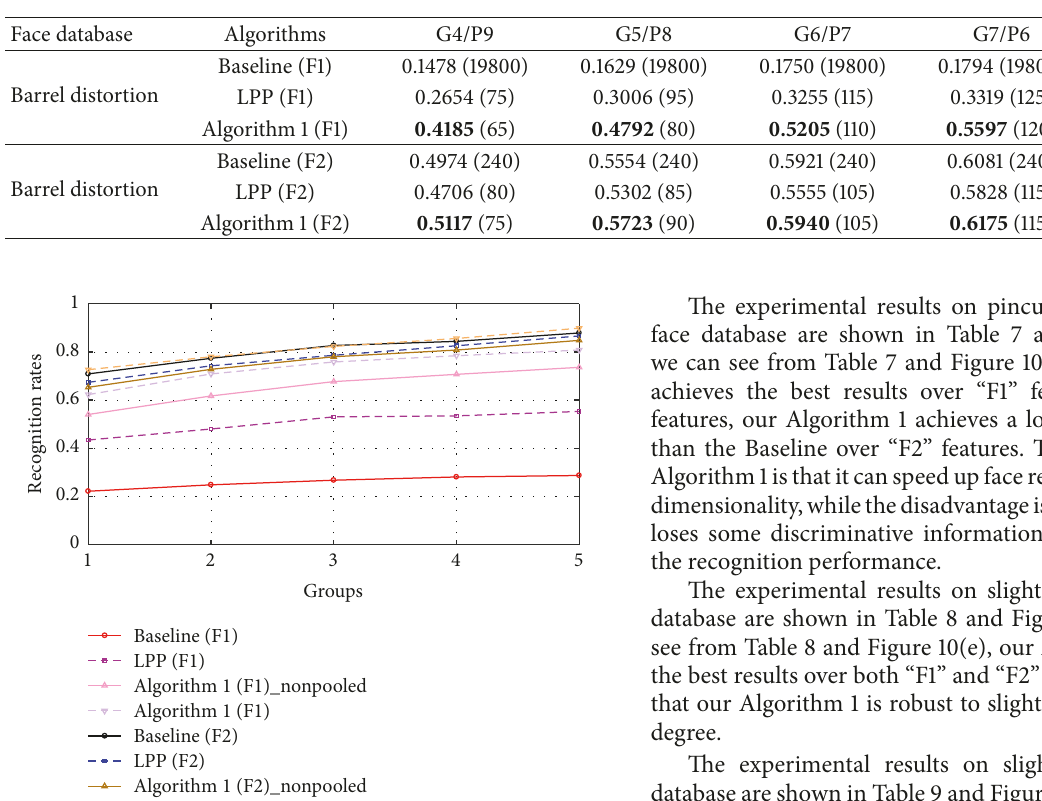
Table 5: The recognition rates on barrel distortion AR face database over “F1” and “F2” features; recognition rates (dimensionality).